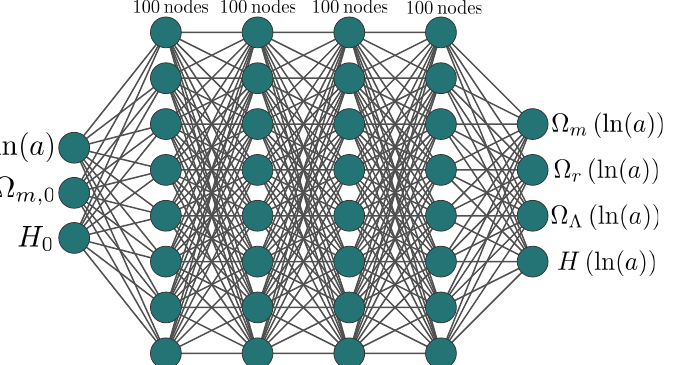
Figure 5. In this architecture the input corresponds to the initial conditions Ω m ,0 and H 0 , and the domain variable N = ln ( a ) . The MLP outputs are the solutions of each parameter Ω i and H , in terms of ln ( a )